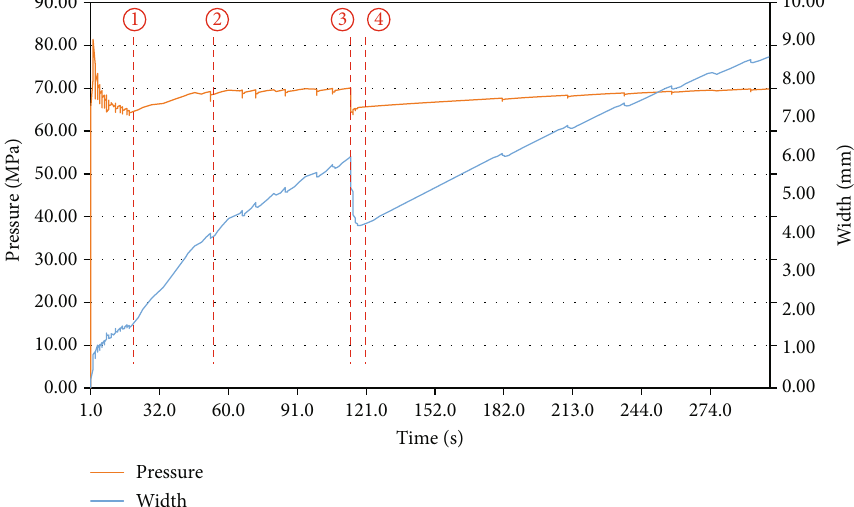
Figure 14: The responses of injection pressure and fracture width during height growth in the reservoir with symmetric mud